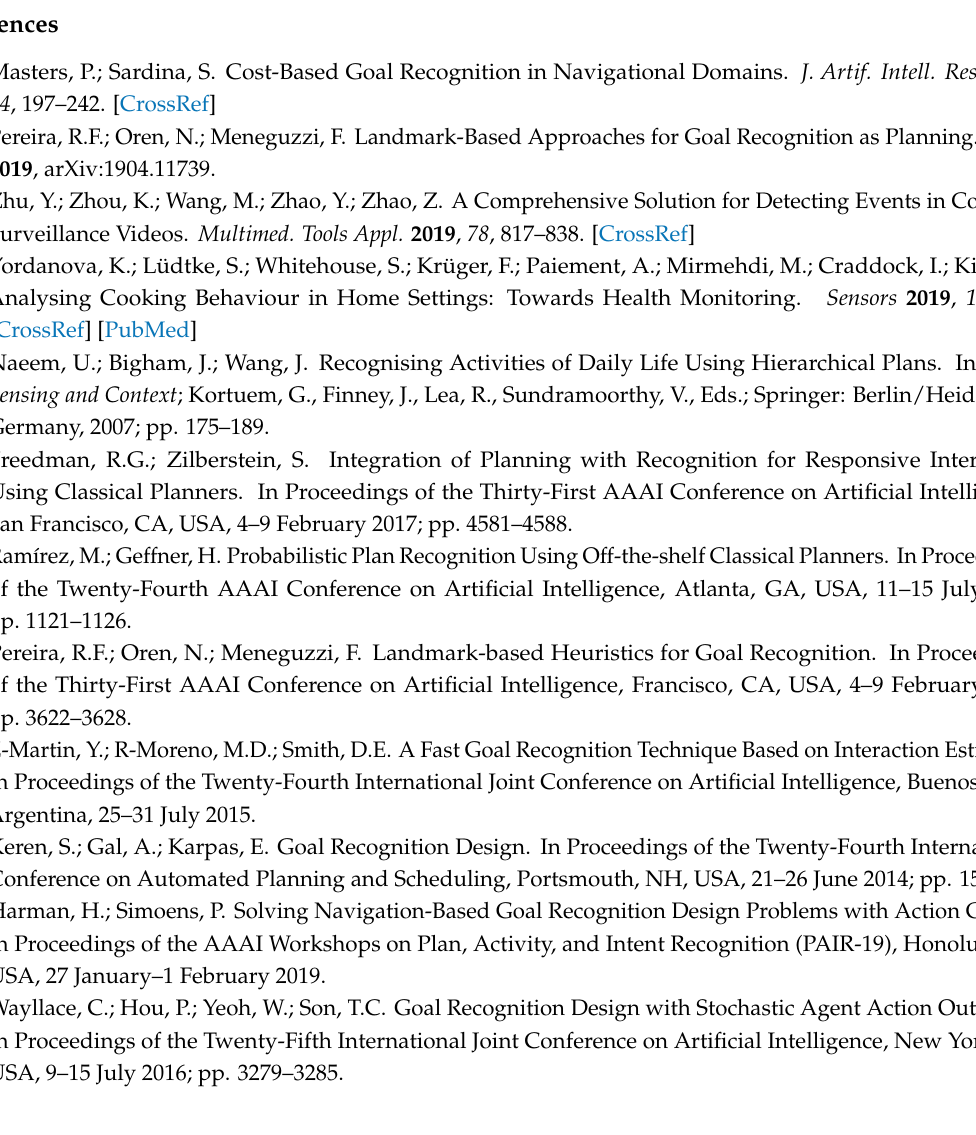
Figure A5. Results for an increasing grid size. The results of our Action Graph approach are indicated by blue circles, pruned-reduce [10] is shown with red